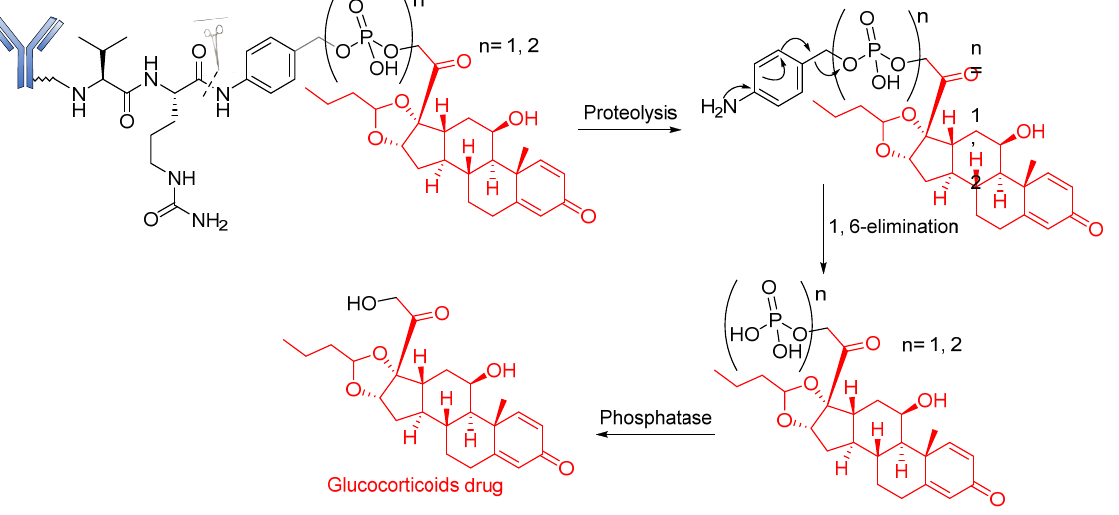
Figure 14. The mechanism by which an ADC containing pyrophosphate is released.